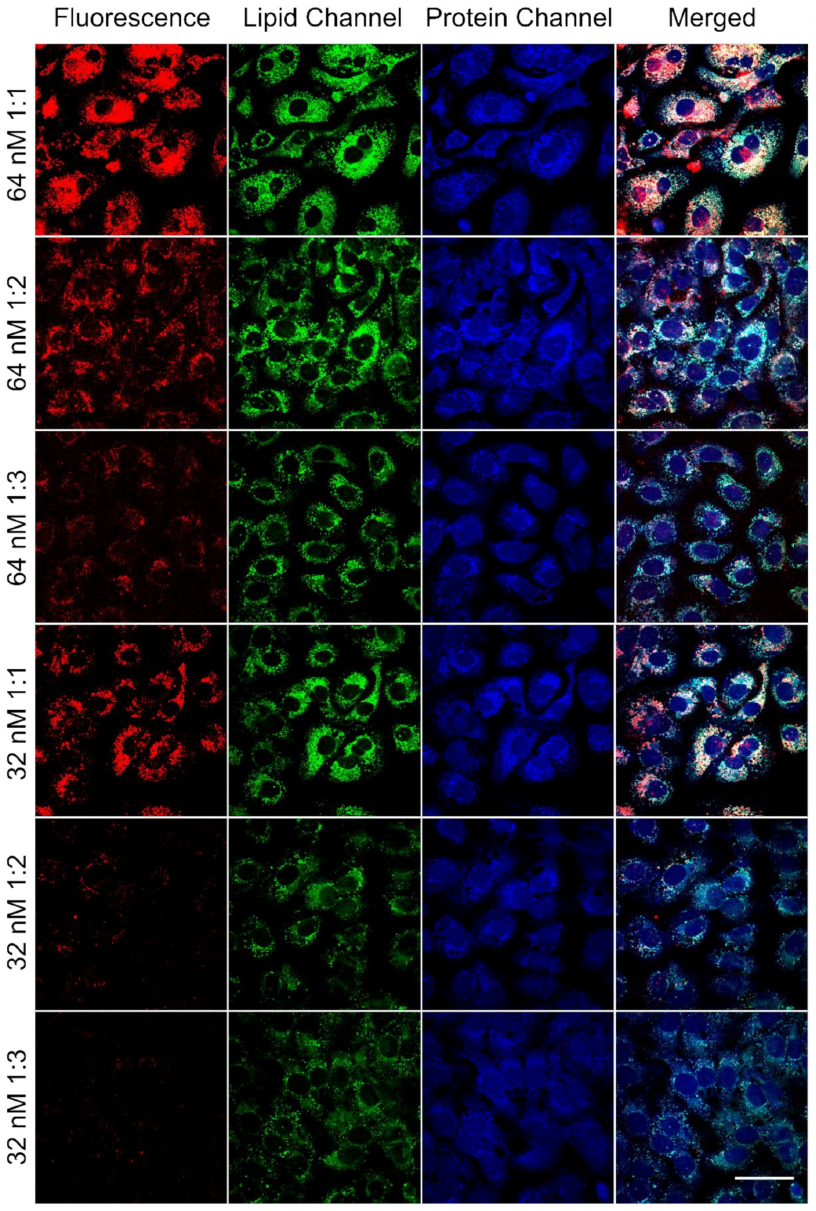
Figure 5. SRS and fluorescence images of SK-OV-3 cells treated with PEGylated 1:1, 1:2 and 1:3 DC-chol/DOPE lipoplexes at lipid concentrations of 64 and 32 nM. Lipid to DNA ratio (1 µ M lipid to 15 µ g/mL DNA) remained the same in 64 and 32 nM lipoplex groups. The images show overlap of the protein (pseudo blue), lipid (pseudo green), and FAM fluorescence (pseudo red) distribution in the cells. Scale bar: 50 µ